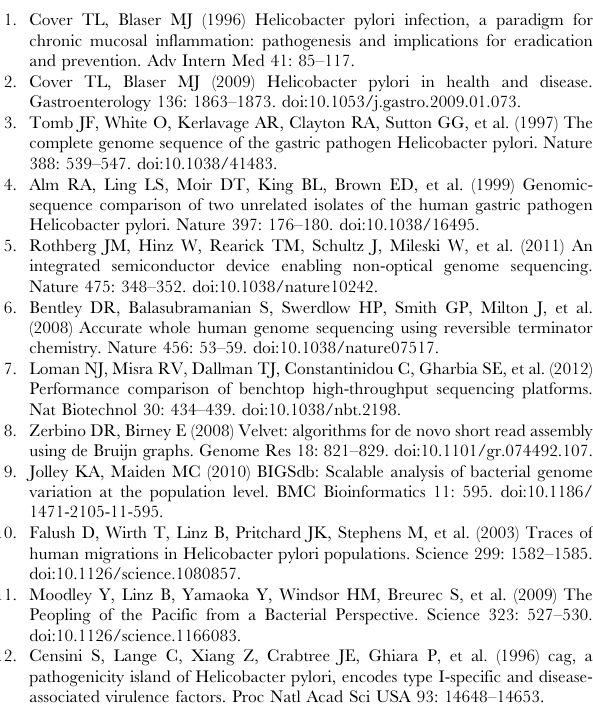
Figure S4 GC content analysis of unique 31-mers. Modified Boxplots of the GC content for all unique 31-mers that map to the reference genomes. (a) represents a subset of the Ion Torrent data (b) represents a subset of the Nextera data and (c) a subset of the Nextera XT data. The dark horizontal line represents the median, upper and lower limit of the box represents 1.5 times the interquartile range, the whiskers represent the largest or smallest non-outlier values and circles represent putative